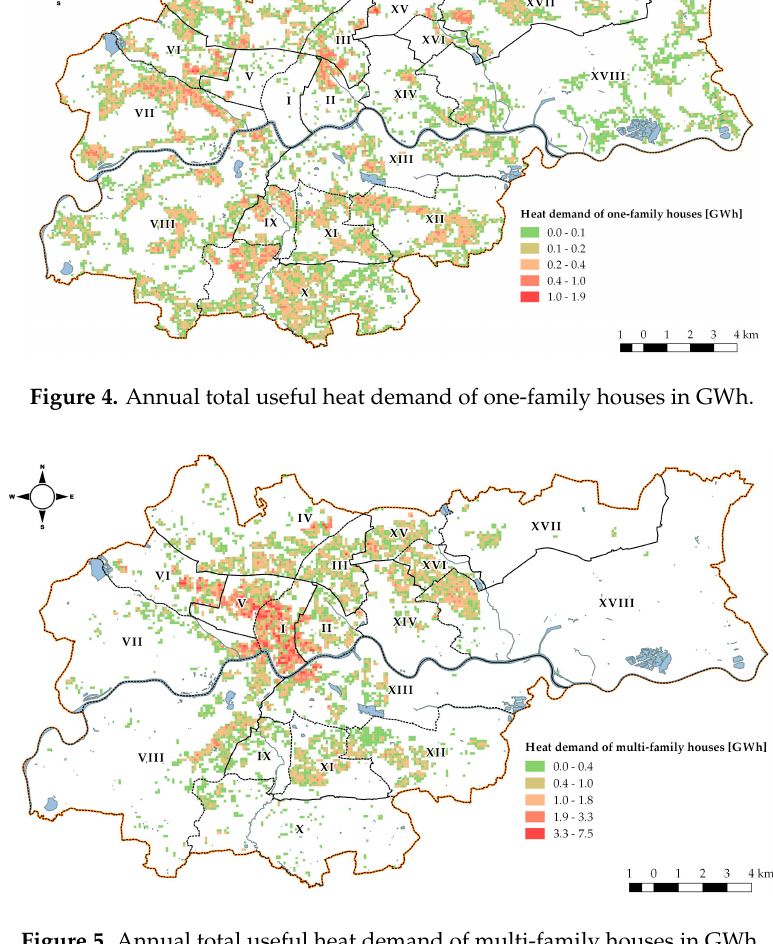
Figure 5. Annual total useful heat demand of multi-family houses in GWh.